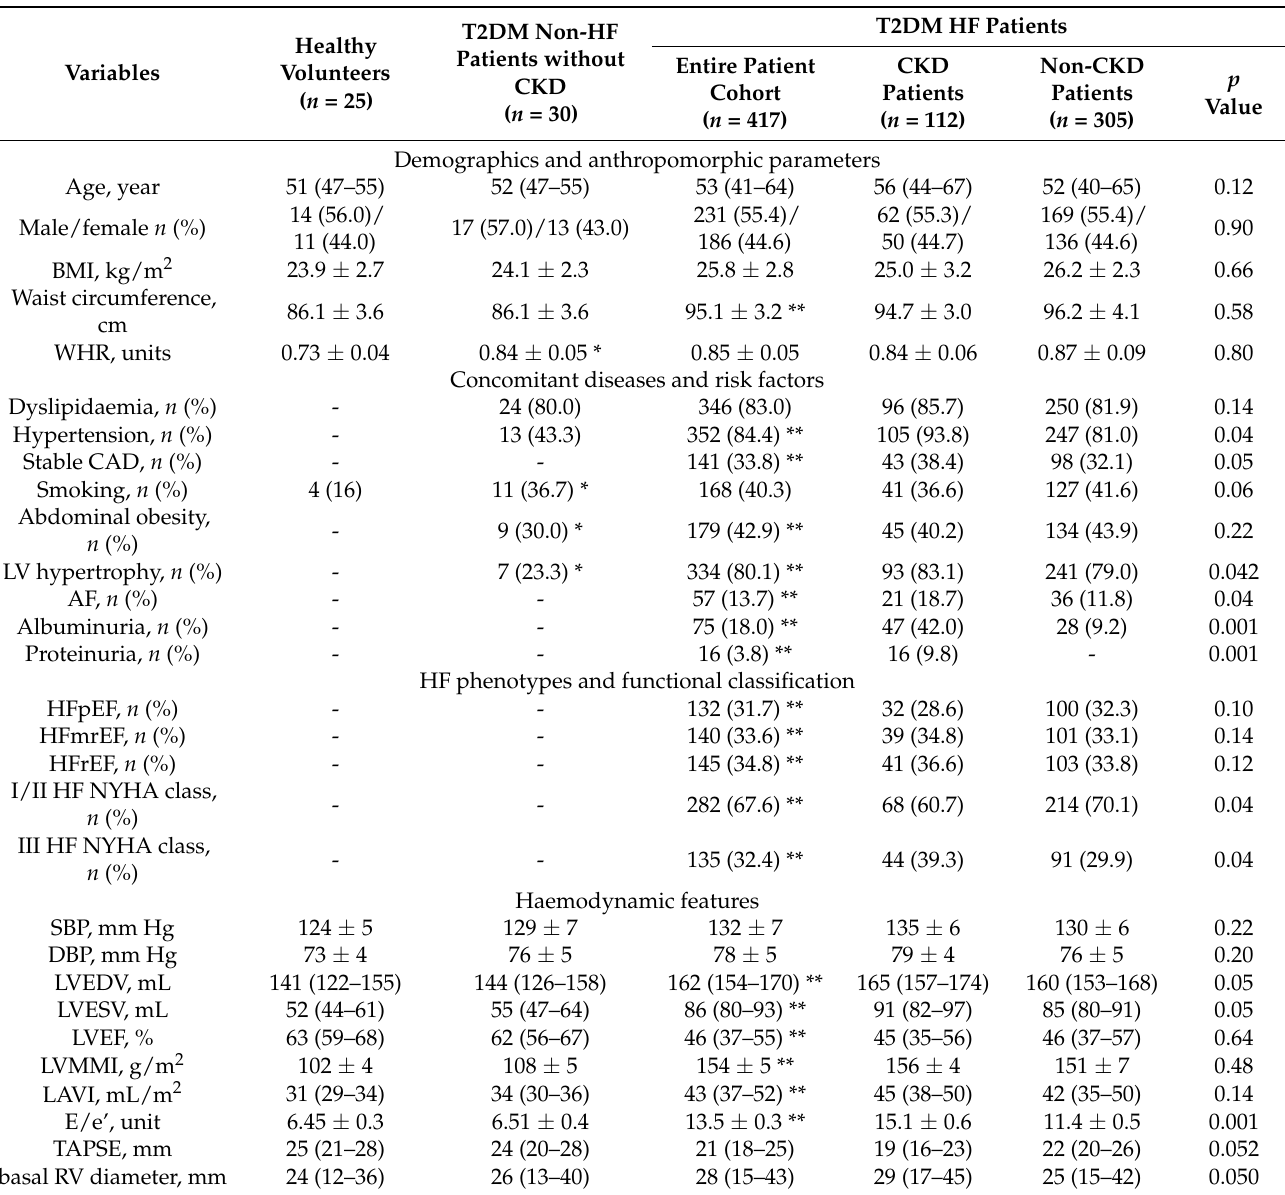
Table 1. Baseline general characteristics of eligible T2DM patients compared with healthy volunteers and T2DM non-HF